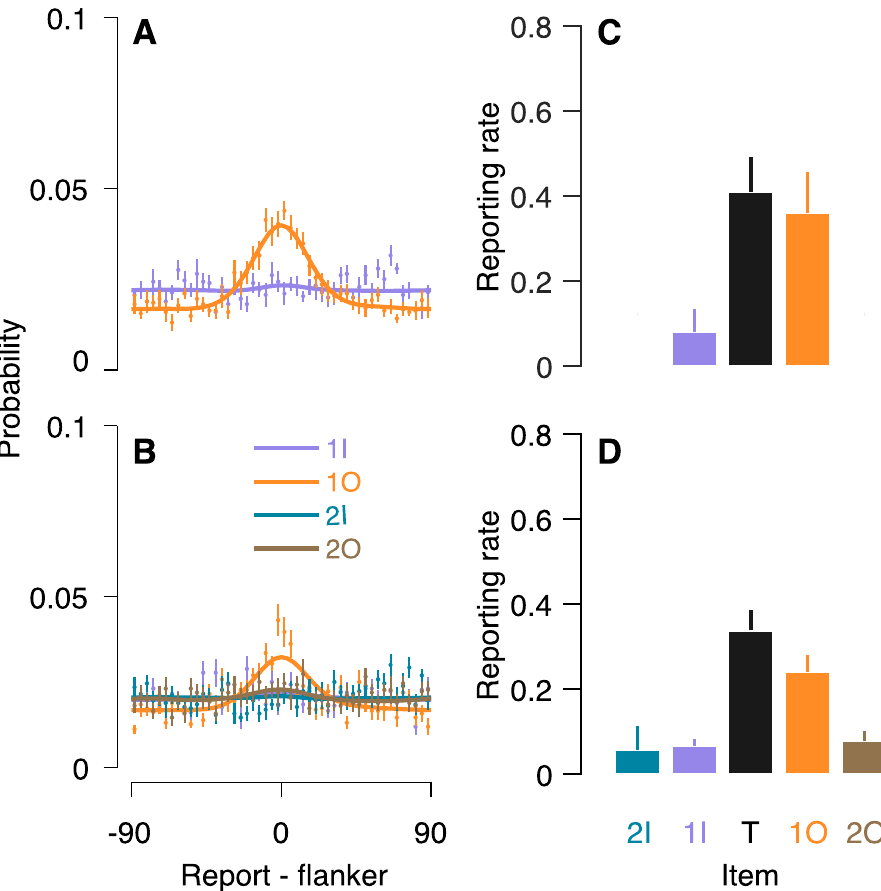
Figure 4. Misreporting the outer flanker as the target in “Experiment 1”. ( A , B ) Distribution of reports around the value of each flanker (0) for the ( A ) two-flanker and ( B ) four-flanker conditions, along with the fitting (solid lines) of the two-misreport model and the four-misreport model respectively. ( C , D ) Reporting rates for each item in the two-flanker ( C ) and four-flanker ( D ) conditions. Flanker report rates are the fitted independent β to each flanker in the two-misreport ( C ) and the four-misreport (σ) ( D ) models. 2I 2nd inner flanker, 1I 1st inner flanker, T target, 1O 1st outer flanker, 2O 2nd outer flanker. Error bars are within subject ± 1